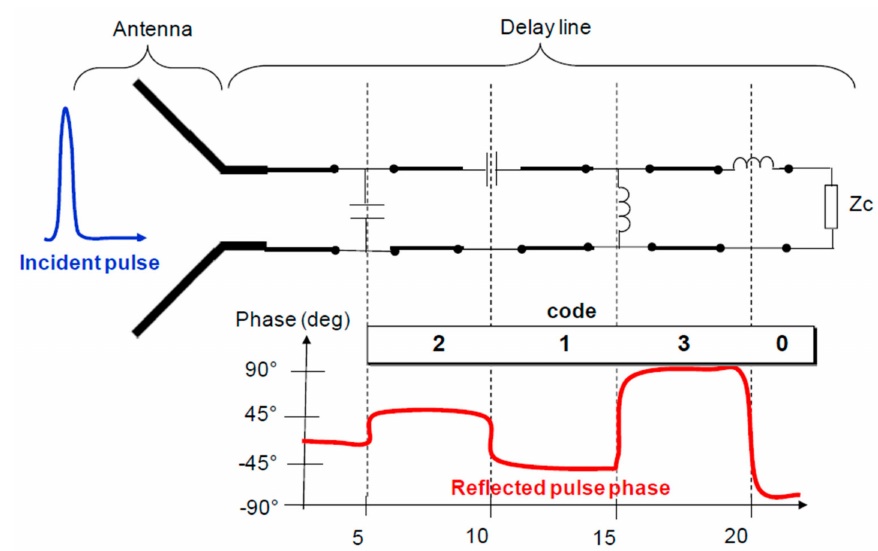
Figure 10. Temporal encoding based on the phase modulation of the input pulse to the tag. Figure extracted from